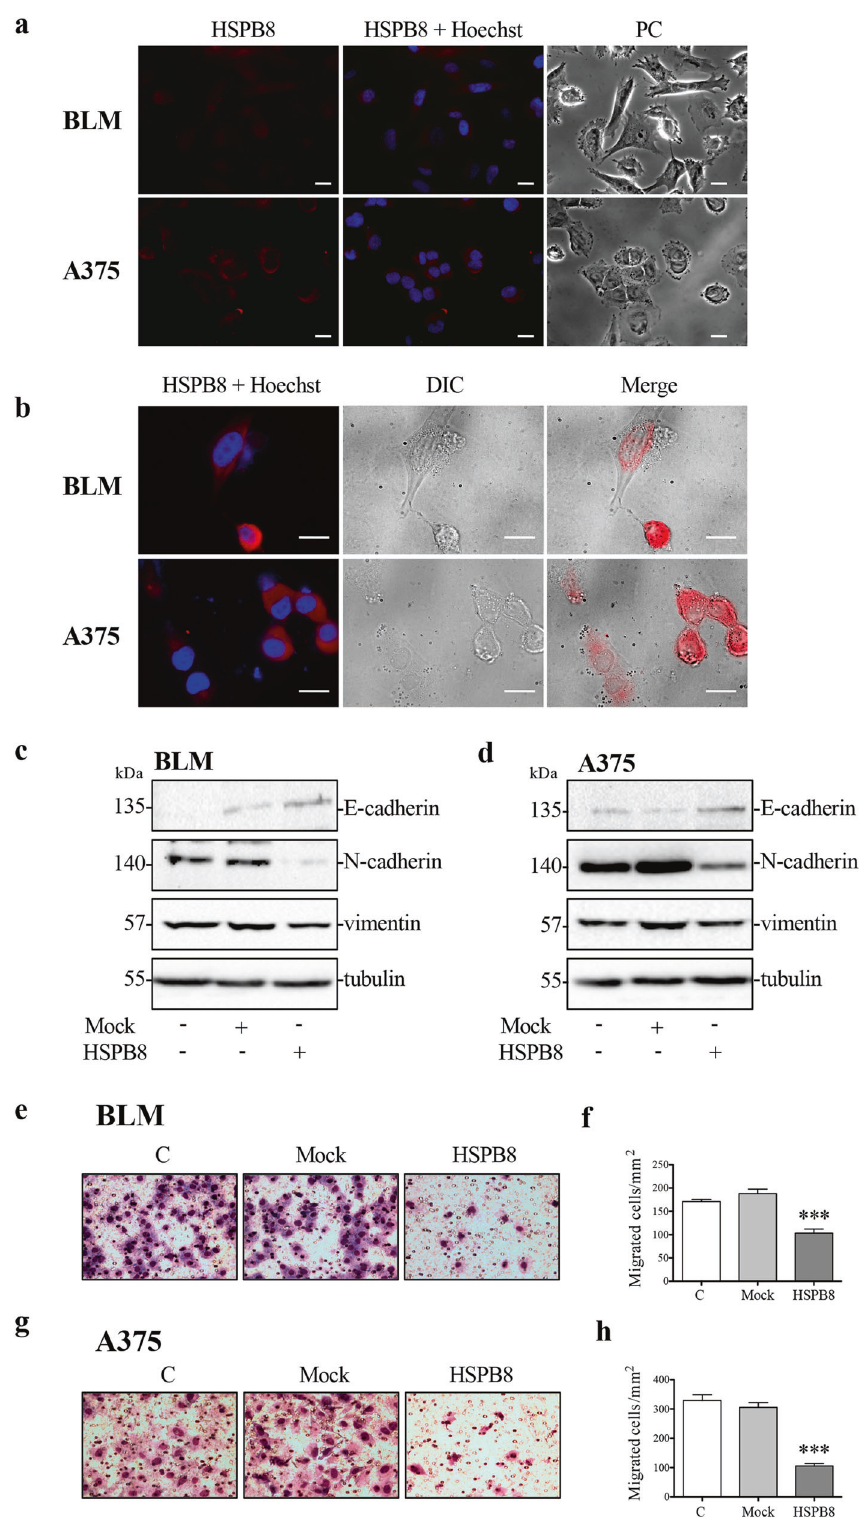
WBs show that both cell lines express low levels of E-cadherin and high levels of N-cadherin and vimentin, compatibly with mesenchymal-like phenotypes. HSPB8 overexpression induces a reversion of EMT-like phenotype increasing E-cadherin